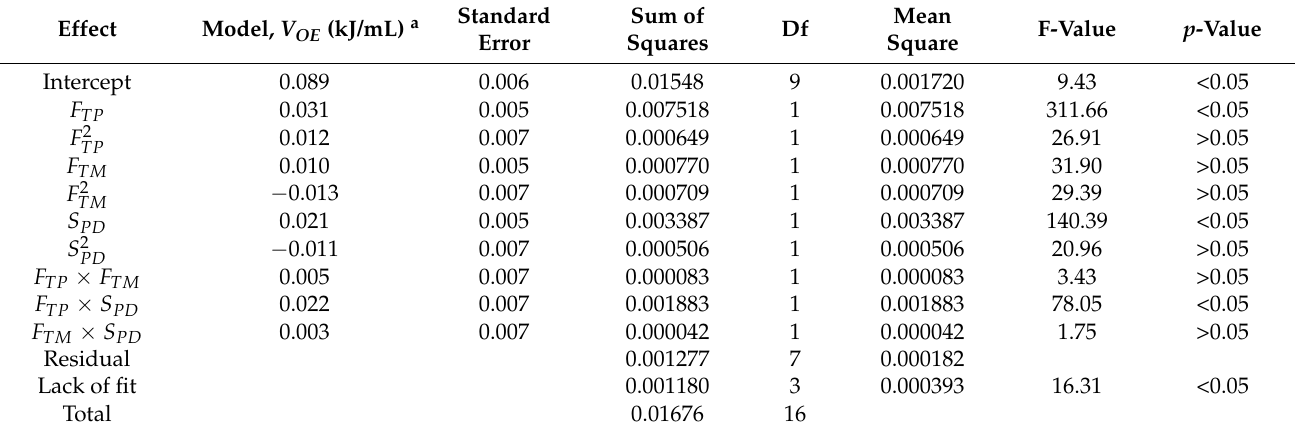
Table 9. Regression analysis of volume of oil energy, V OE (kJ/mL), under freezing